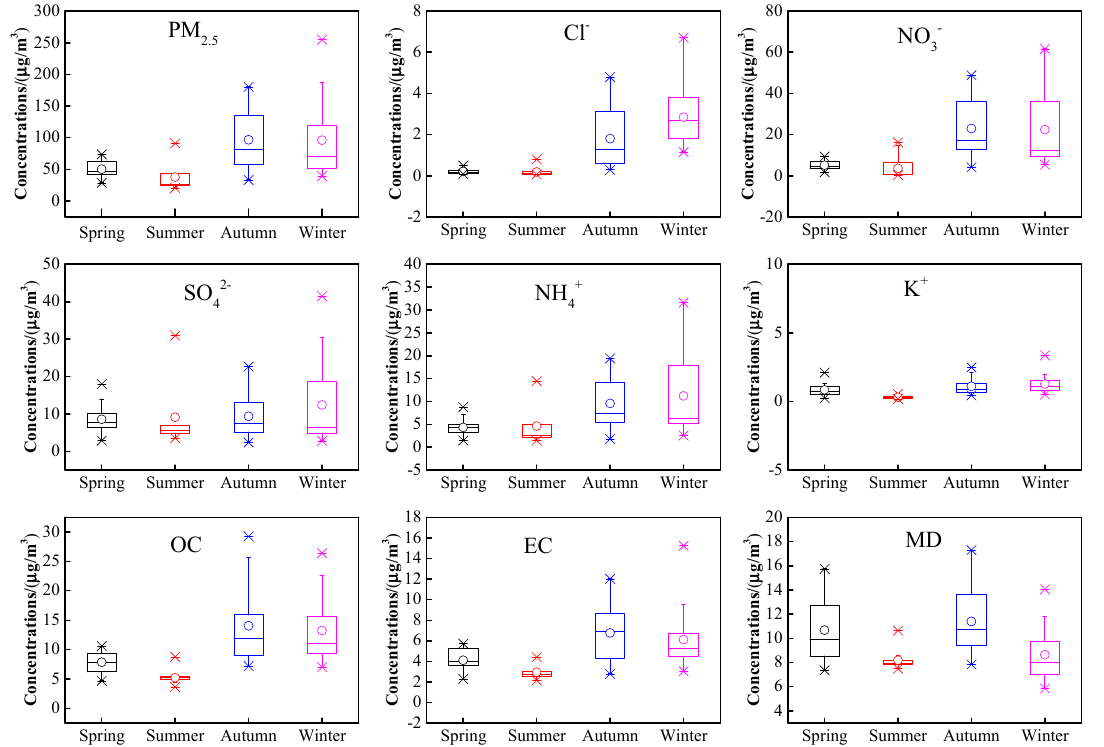
Figure 3. Seasonal distributions of PM 2.5 and its major chemical components. Shown in each sub-figure are the mean (dot symbol), the median (horizontal line), the central 50% data (25th–75th percentiles, box), and the central 90% data (5th–95th percentile, whiskers). Note: MD is short for ‘mineral dust’.